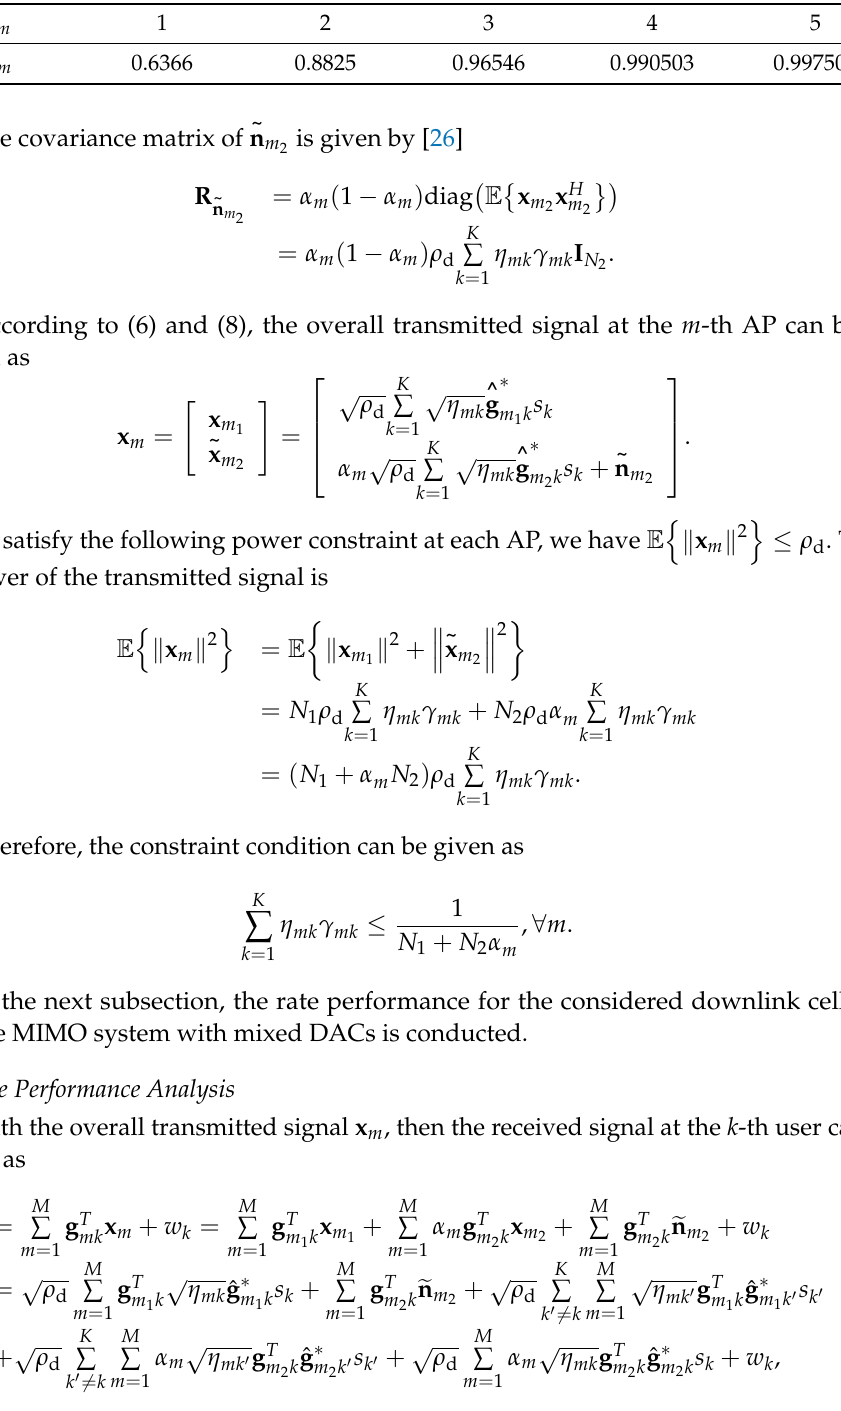
Table 1. Quantization Bits b m for Coeficient α m